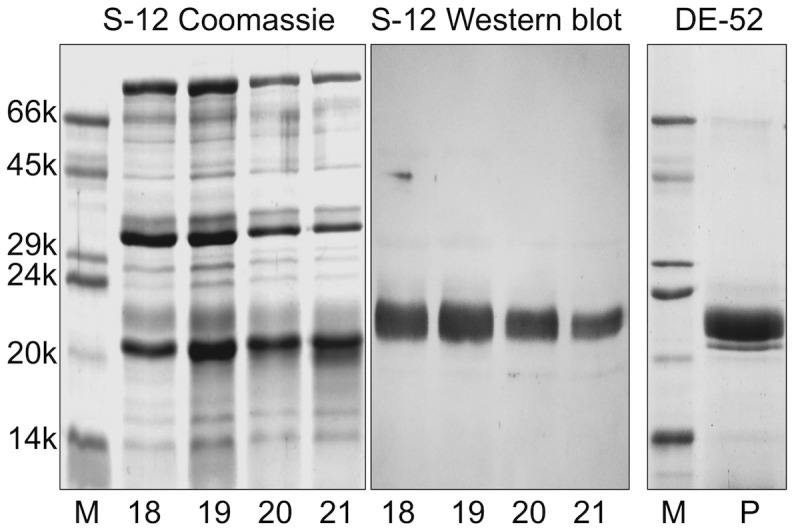
Purification of the rabbit seminal fluid OBP.A sample of crude seminal fluid, as obtained after sperm centrifugation, was resolved at first by gel filtration chromatography on a Superose-12 column and then by anion-exchange chromatography on a DE-52 column (see Materials and Methods section for details). The protein was eluted as a pure component, as verified by SDS-PAGE.